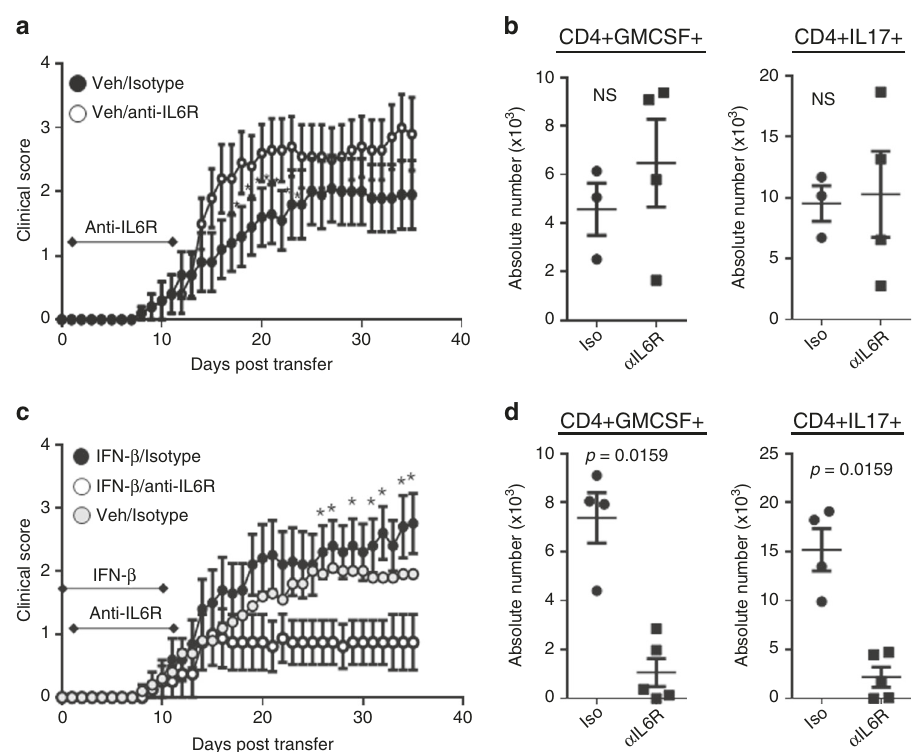
Fig. 7 IL-6 blockade attenuates IFN- β -treated TH17-EAE. TH17-EAE mice, either treated with IFN- β or vehicle, were also treated with either anti-IL-6R or an isotype control every 5 days from days 1 – 11. a Effect of treatment with anti-IL-6R ( n = 10) or isotype ( n = 10) control on the clinical scores of vehicle- treated TH17-EAE. Data were pooled from two independent experiments. b Number of CD4 + T cells that express GM-CSF and IL-17 in spinal cords of vehicle-treated mice (day 35). c Effect of anti-IL-6R ( n = 8) or isotype ( n = 10) treatment on the clinical scores of IFN- β -treated TH17-EAE. Data were pooled from two independent experiments. Vehicle/isotype treated mice were also plotted for reference. d Number of CD4 + T cells that express GM-CSF and IL-17 in the spinal cords of IFN- β -treated EAE mice (day 35). Statistical analysis was performed using Mann – Whitney tests ( P < 0.05). Error bars indicate the S.E.M. Results are compiled from two independent